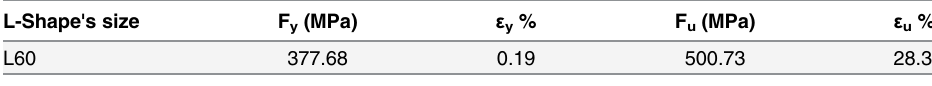
Table 3. Steel properties used in push-out